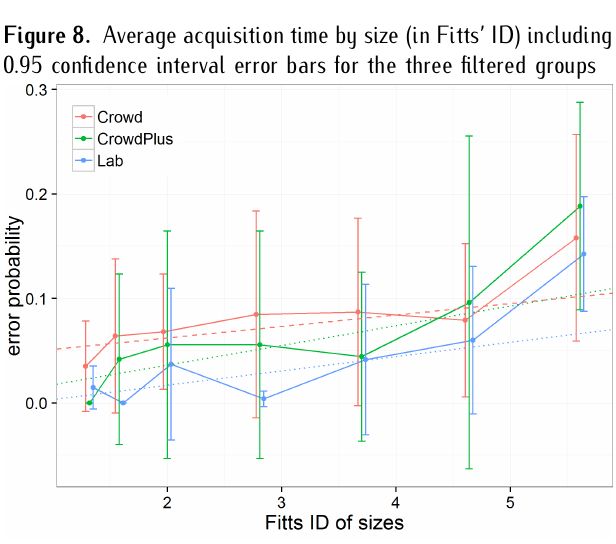
Figure 9. Error mean per repetition by size (in Fitts’ ID) including 0.95 confidence interval error bars for the three filtered groups.